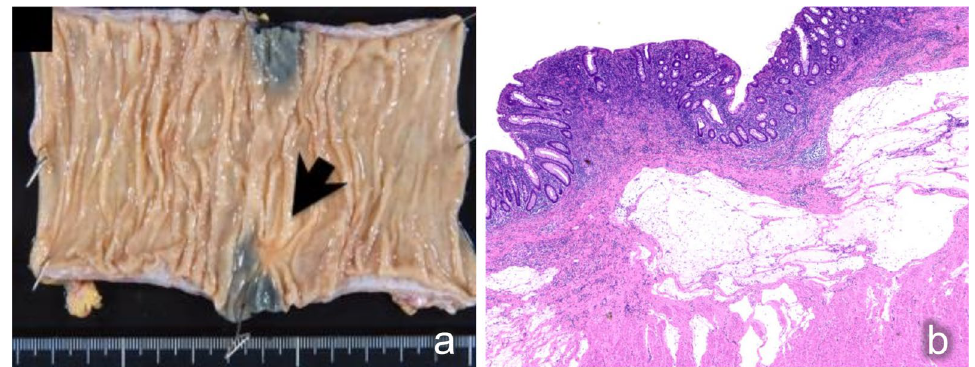
Fig. 4 Resected specimen and histopathological examination findings. a The resected specimen left only a discolored scar, and the tumor had disappeared. b Histopathological examination revealed mucosal regeneration and a mucus nodule in between the submucosal and muscular layers, with no cancer cells. All of the resected specimens also showed no malignancy